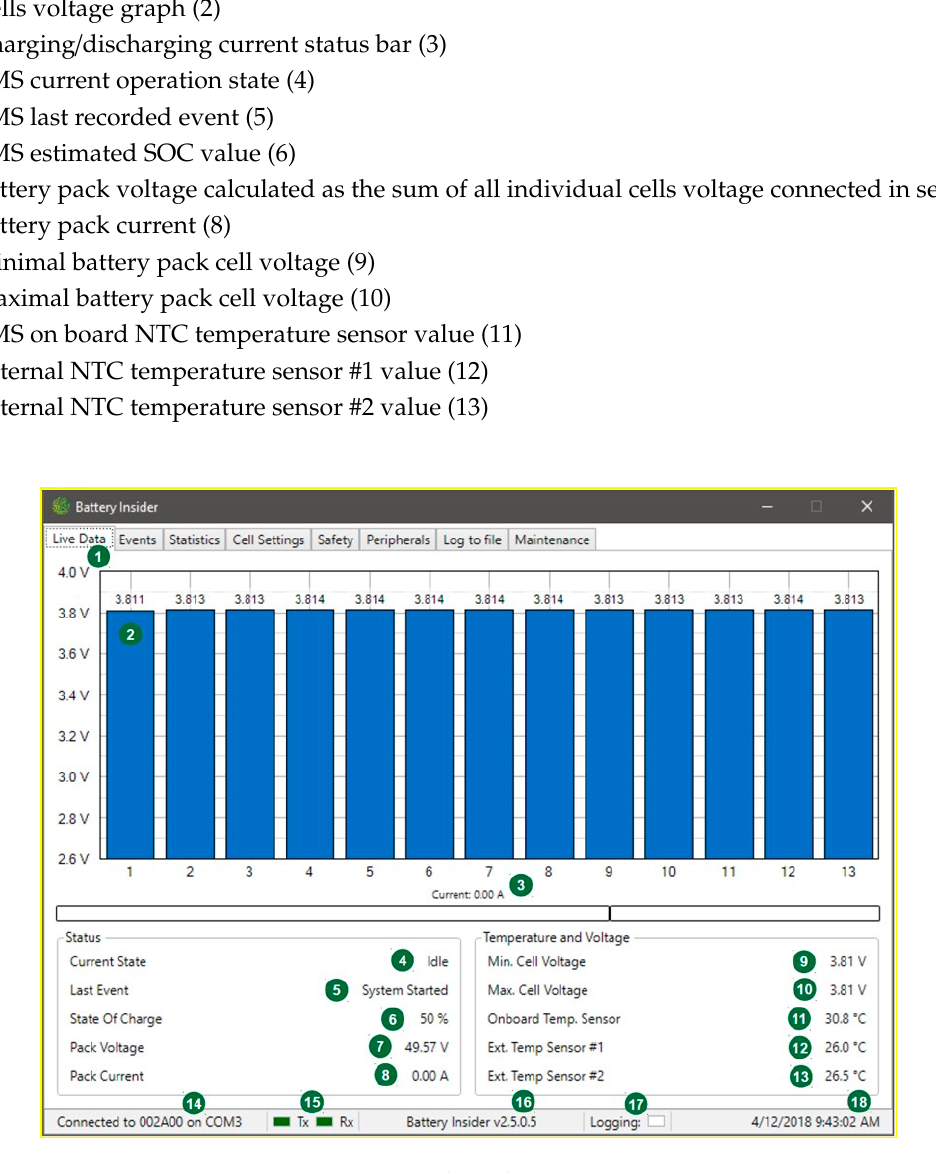
Table 8. ALO propeller main characteristics.